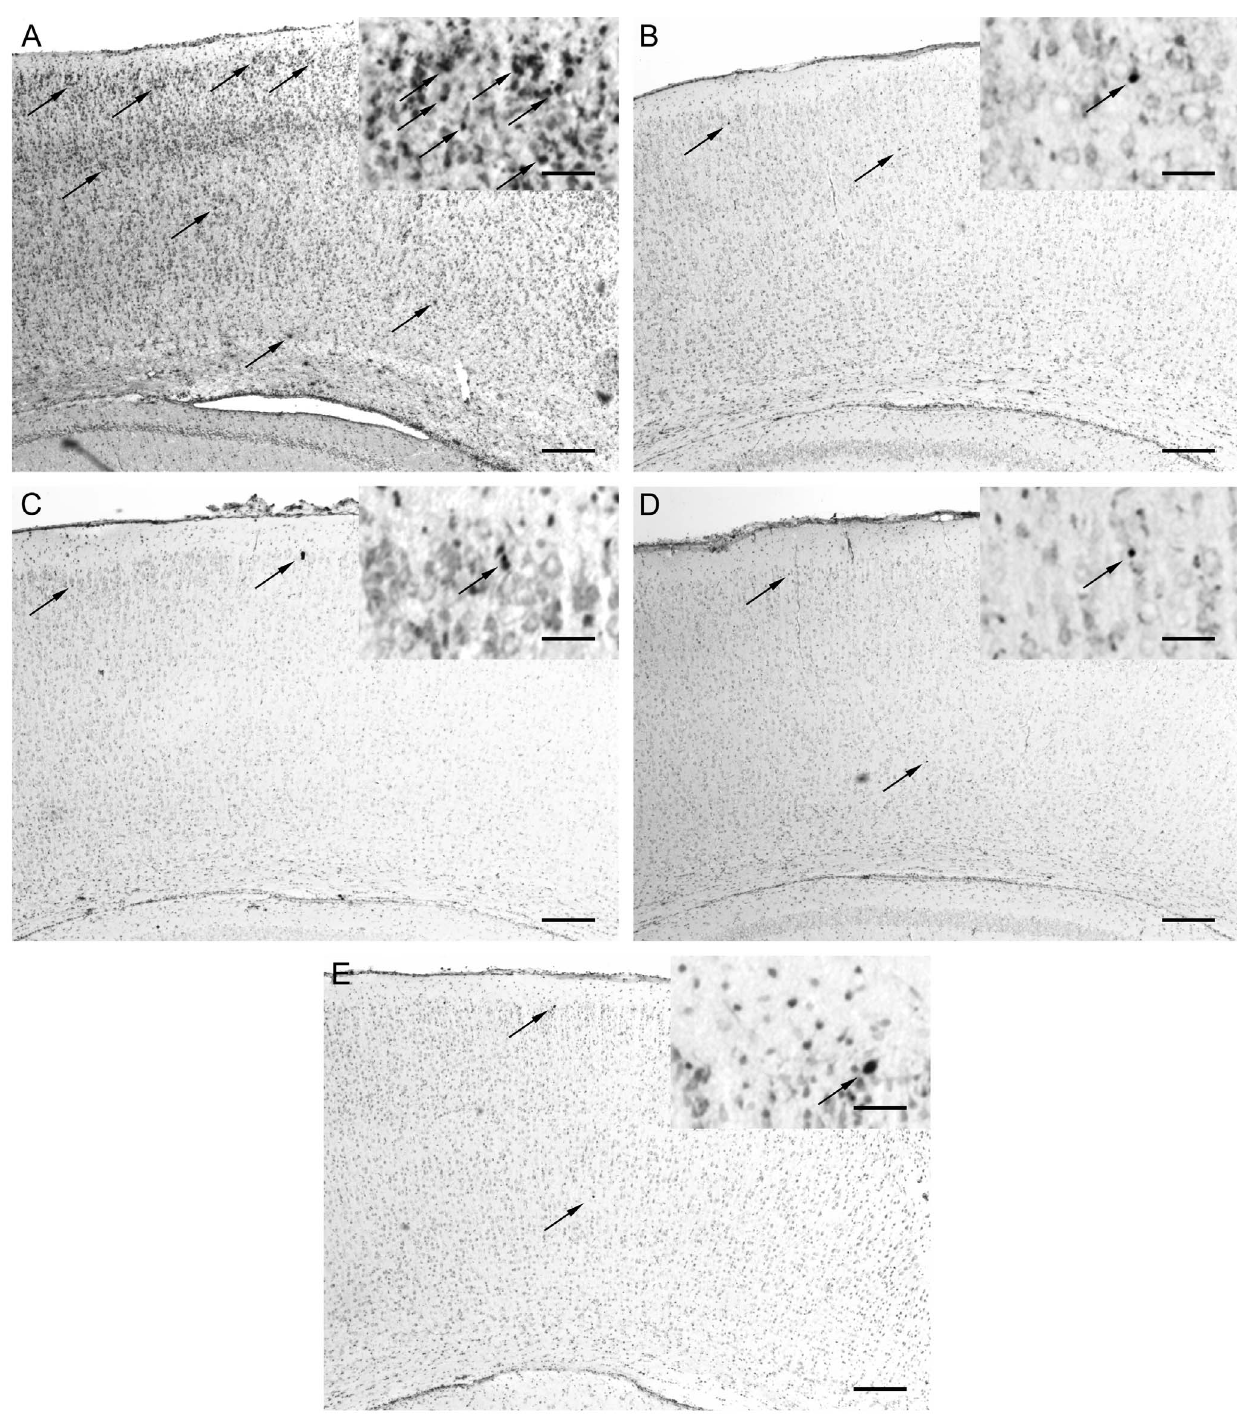
Figure 3. Phenobarbital and bumetanide, singly or in combination, did not increase constitutive cell death in P10 rat pups. Representative photomicrographs and magnified insets of TUNEL staining on 16 m m coronal sections of parietal cortex 48 h after treatment with (A) MK801 (positive control), (B) vehicle (DMSO in 0.9% saline) (n=10), (C) phenobarbital (n=11), (D) high dose bumetanide (n=11), or (E) combined phenobarbital and high dose bumetanide (n=8). Sections were lightly counterstained with methyl green. Pictures were taken at low power to maximize scoring, and magnified insets show detail. Other regions examined were amygdala, caudate-putamen, hippocampus, and thalamus. Apoptotic cells can be seen as dark pyknotic nuclei (arrows denote examples). No treatment significantly increased constitutive apoptosis compared to vehicle when analyzed within each region or in the total area (p=0.129). A P7 rat pup treated with MK801 served as a positive control, and showed numerous apoptotic neurons clustered in layer II but also in other cortical layers. Scale bar=200 m m (inset scale bar=35 m m).